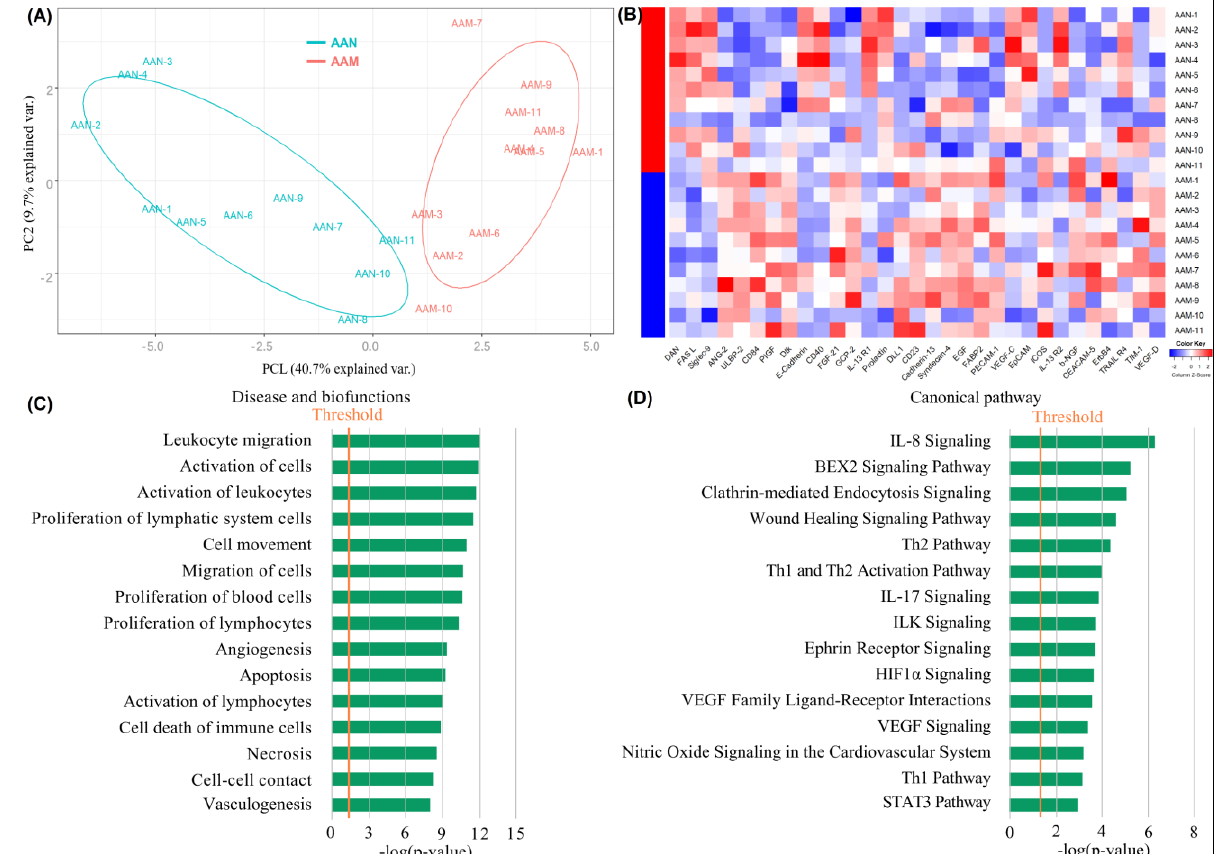
Figure 3. Identification and bioinformatics analyses of differentially expressed proteins between AAM and AAN patients. ( A ) Principal component analysis (PCA) model between AAM and AAN; ( B ) Clustering heatmap of differential proteins between the two groups; ( C ) Disease and biofunction analysis; ( D ) Canonical pathway analysis.